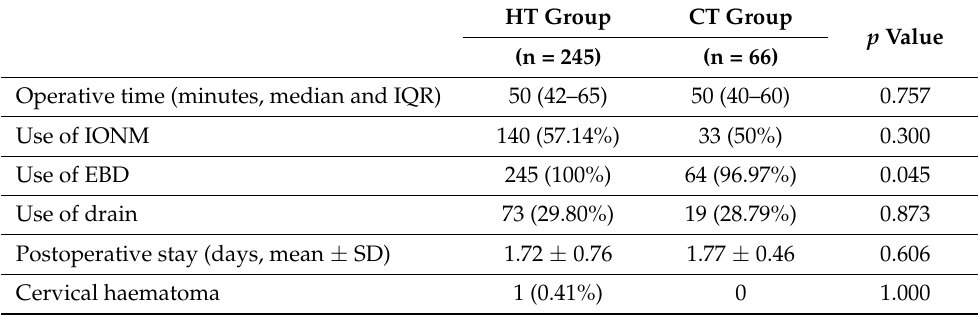
Table 5. Data about surgical procedure, postoperative stay and complications in HT Group and CT